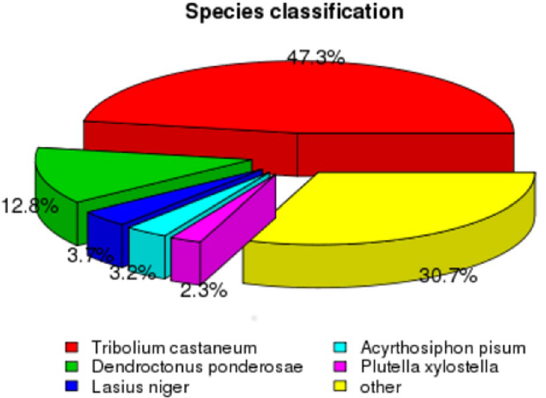
Figure 1. All unigenes sequences (92,259) that had blast annotations against the nr database with a cut-off E-value 10 − 5 were analyzed for species distribution.